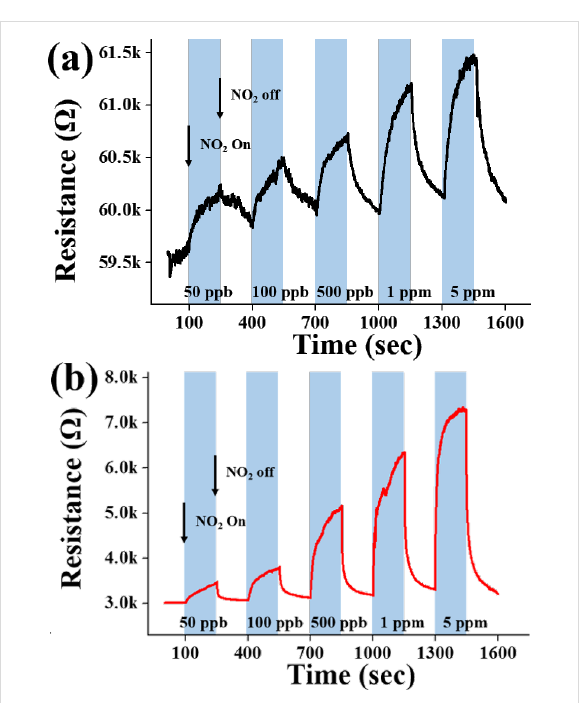
Figure 3: Electrical responses of the gas sensors fabricated from ZnSe nanowires to 50 ppb, 100 ppb, 500 ppb, 1 ppm and 5 ppm NO 2 gas at room temperature (a) in the dark and (b) under UV (365 nm) illumination at 1.2 mW/cm 2